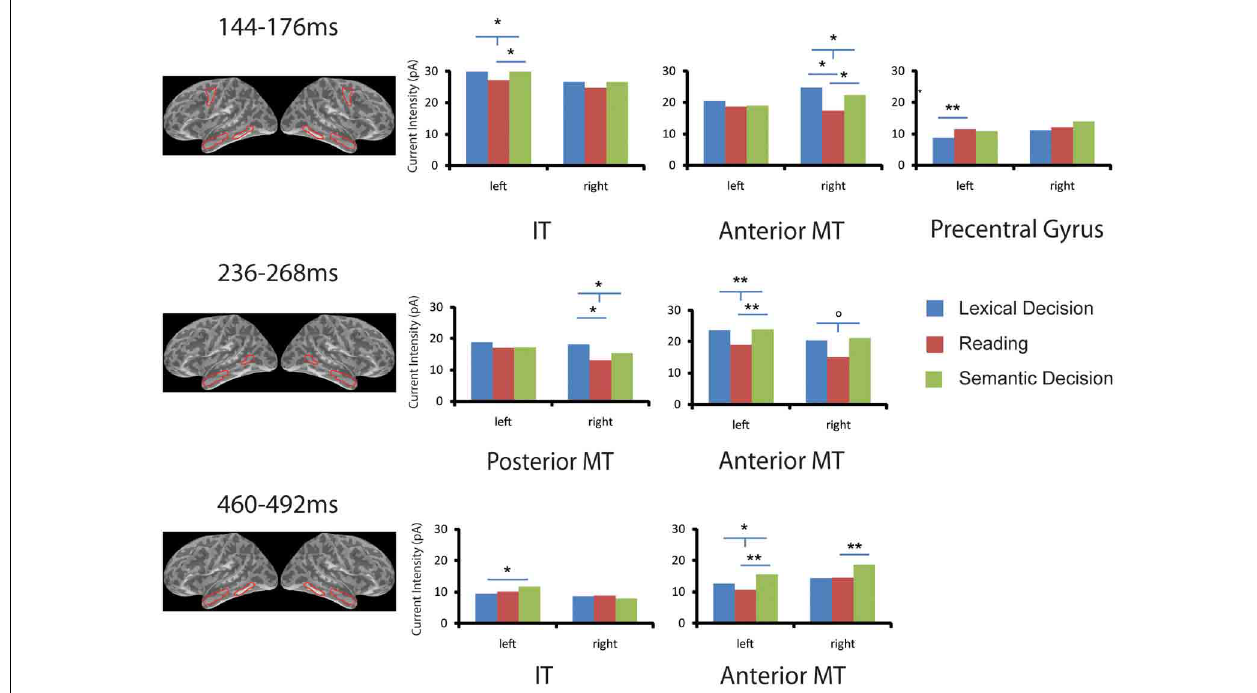
FIGURE 3 | ROI analysis in EEG/MEG source space. Task effects on word activation are shown for six ROIs and in three time windows (144–176, 236–268, 460–492ms) that showed significant family-wise corrected effects of Task in the sensor space analysis (SensorSPMs). For each time window,